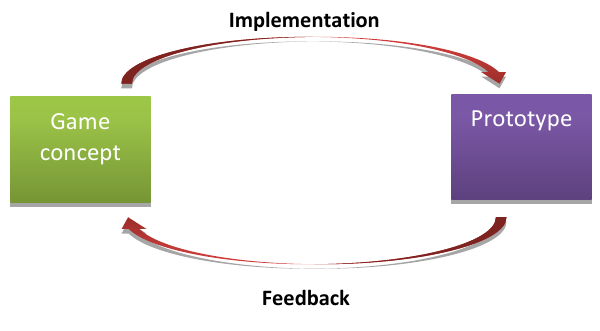
Figure 1. A simple design cycle